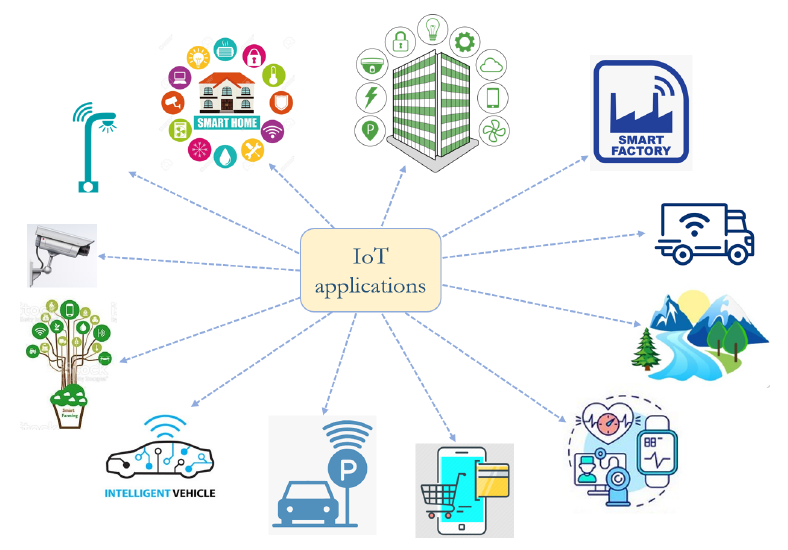
Figure 13. Examples of IoT application